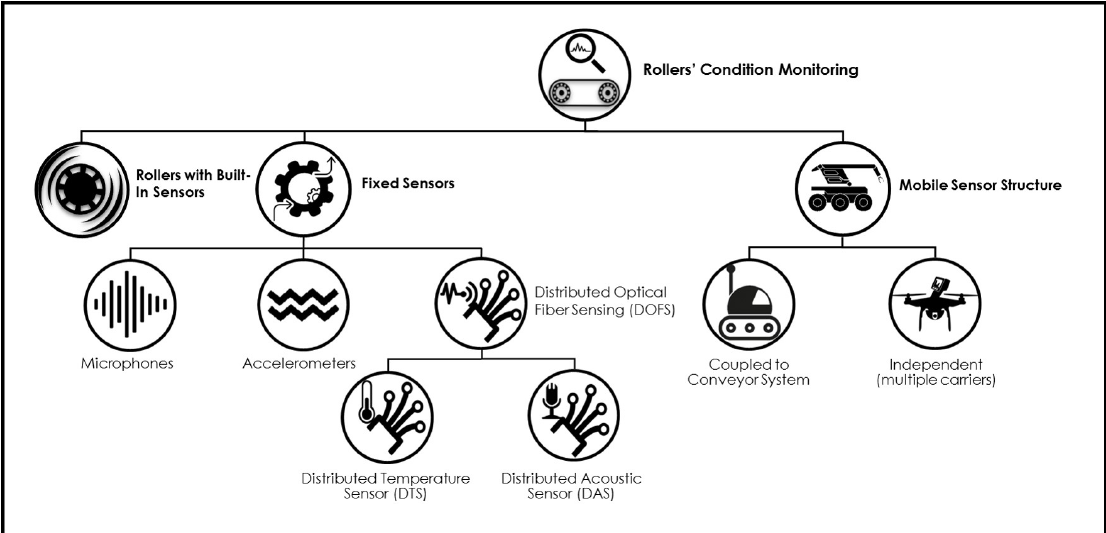
Figure 2. Sensor position and main techniques to monitor the condition of conveyor belt